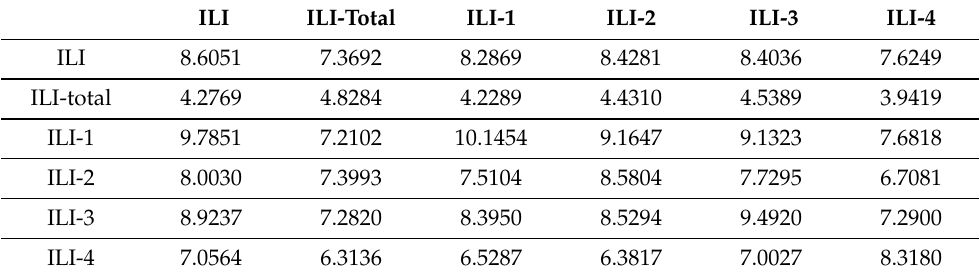
Table 3. Matrix [ AV ] Max ,10,6 .